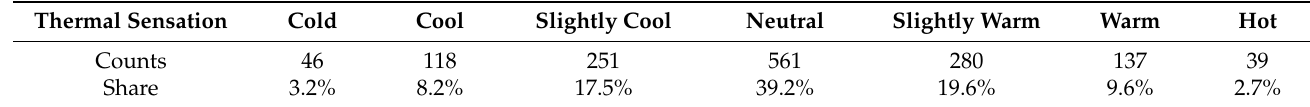
Table 2. TSV statistics obtained at the comfort zone identified in the survey